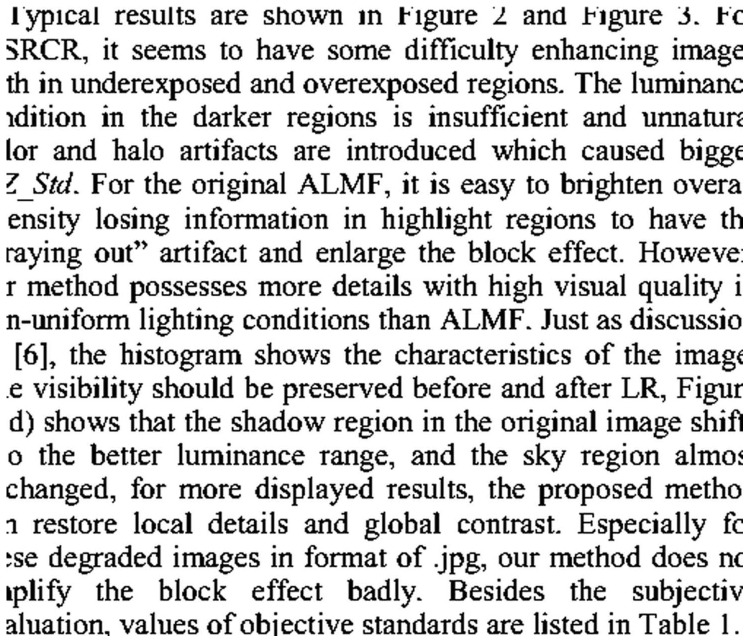
Ideal text image.